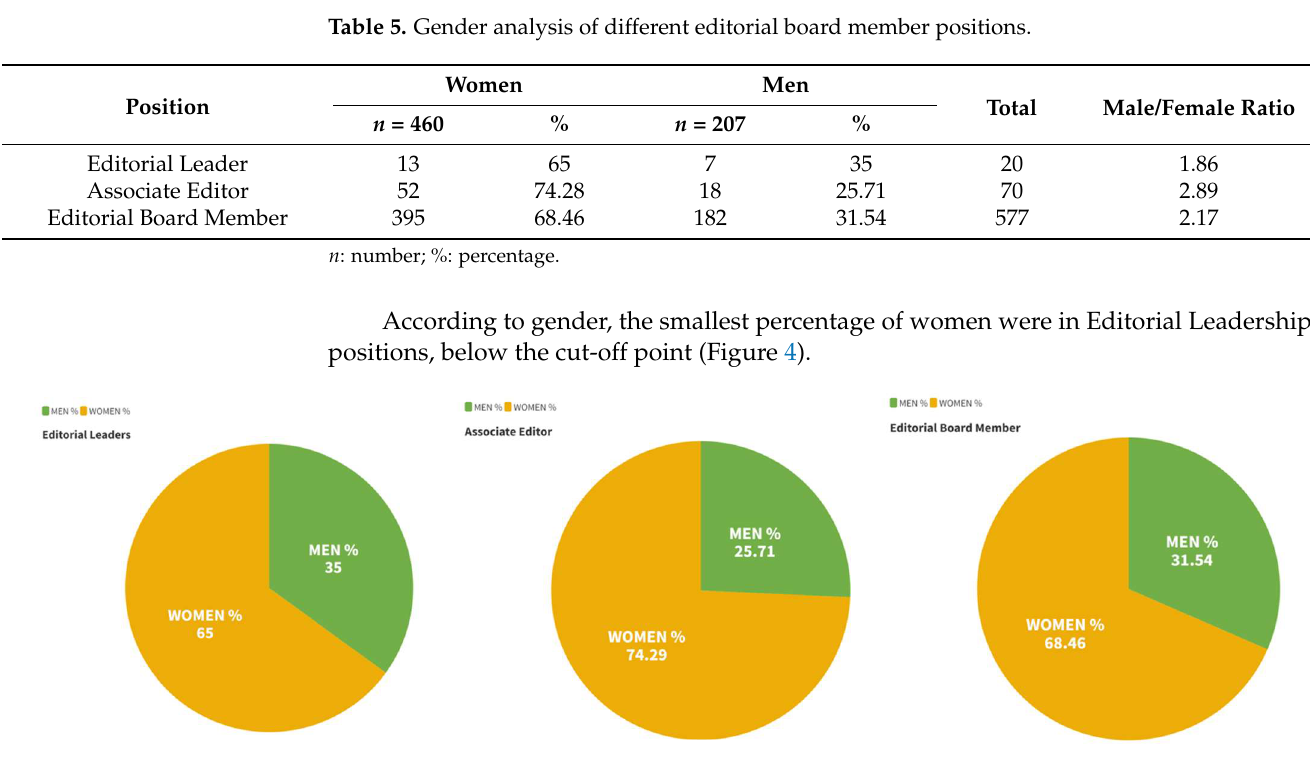
Table 6. Contingency table by genre and editorial position, quartile, journal, and region.